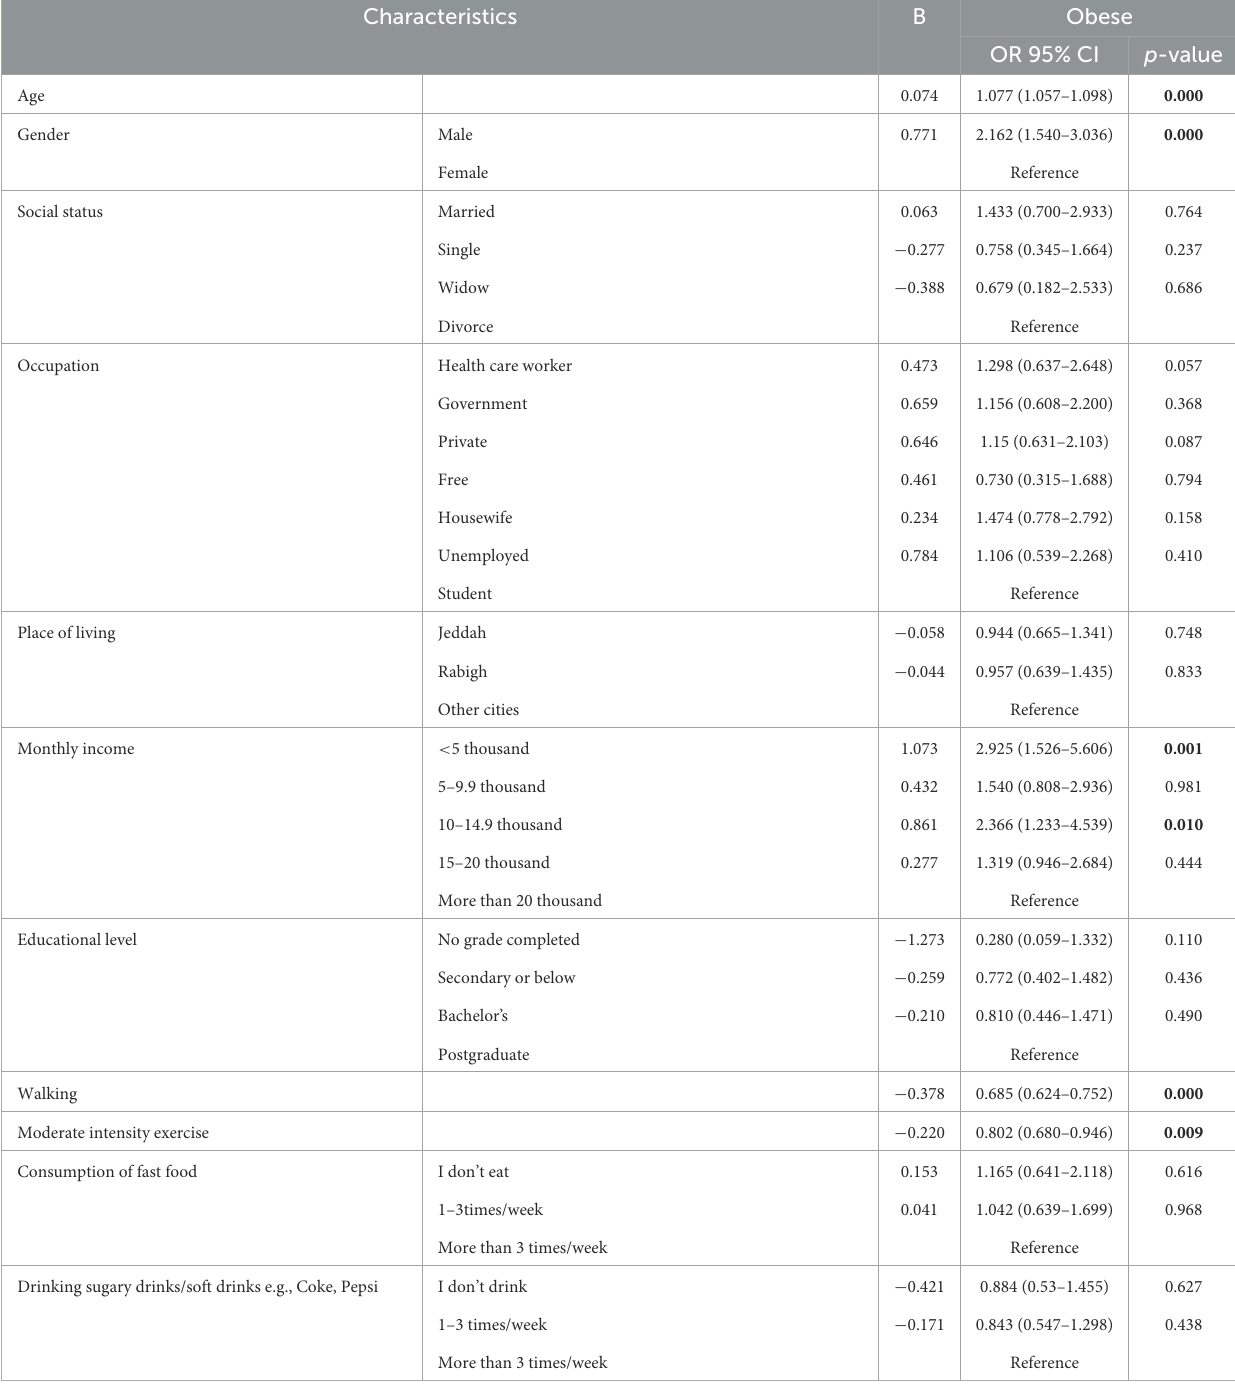
TABLE 5 Association of demographic characteristics and other variables with different